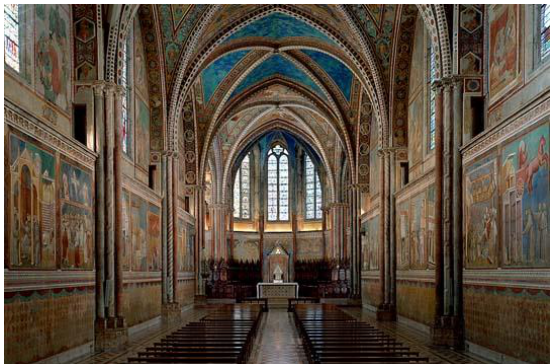
Figure 6. View of the interior of the upper Basilica after